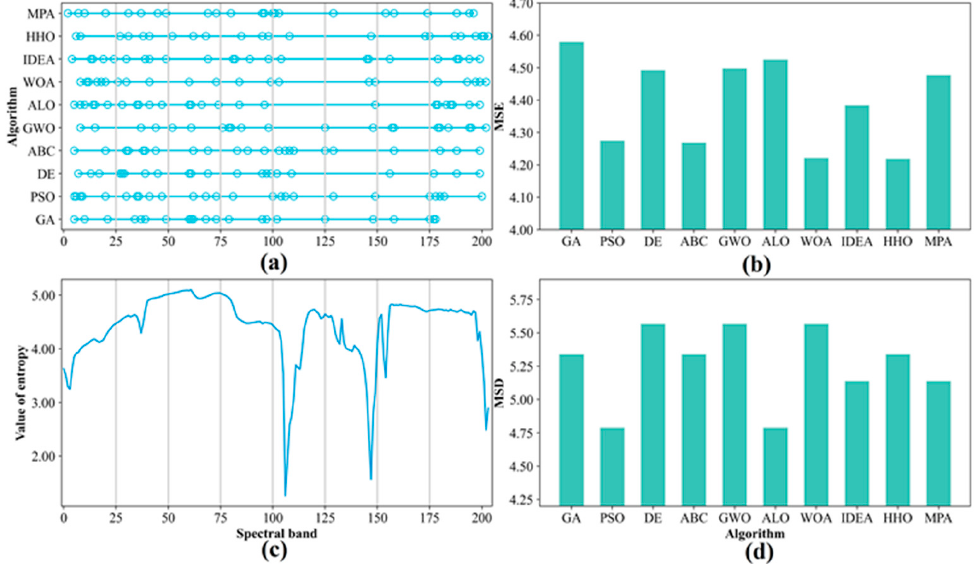
Figure 8. Analysis of the selected bands on the Salinas: ( a ) selected bands from the methods, ( b ) MSE value, ( c ) entropy value of each band of the dataset, and ( d ) MSD value.